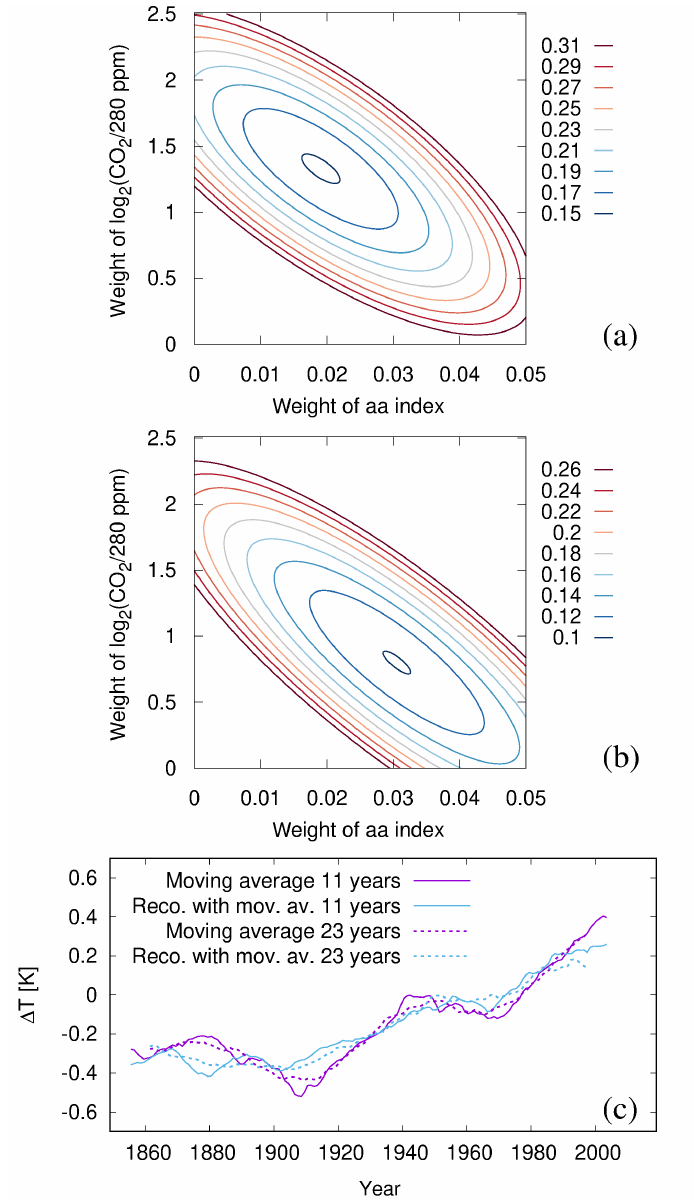
Figure 6. Regression analysis for the reduced data (end year 2008). ( a ) FVU in dependence on w aa and w CO for MAW = 11years, with FVU min = 0.149 reached for w aa = 0.019K/nT and w CO 2 ( b ) The same for MAW = 23years, with FVU min = 0.099 reached for w aa = 0.0305K/nT and = 0.80K. ( c ) The 11-year and 23-year moving averages for the original ∆ T (purple) and for the w CO 2 reconstructed ∆ T (red) when using the optimized values of w aa and w CO